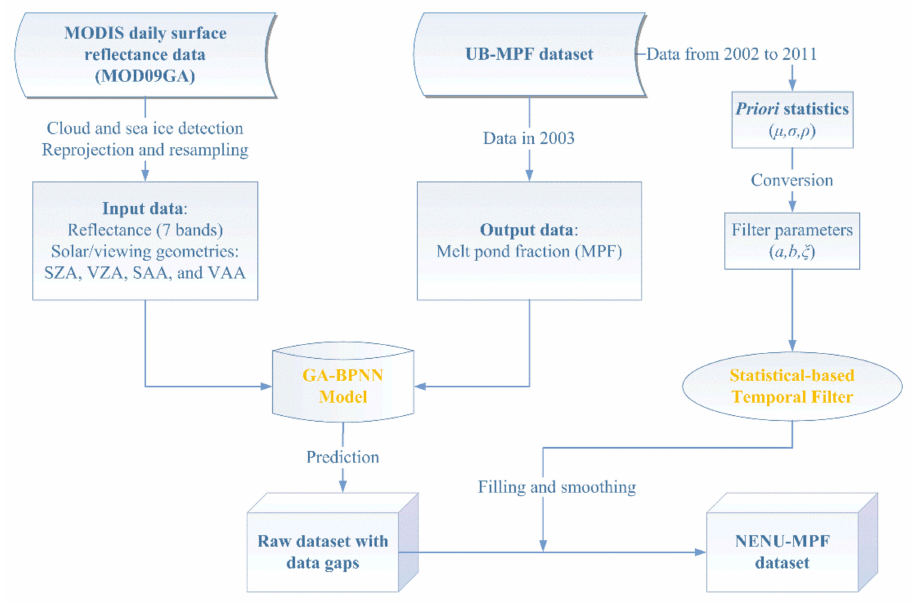
Figure 2. Workflow for generating the long-term spatiotemporally continuous NENU-MPF